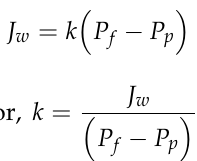
Table 1. Effect of varying feed flow rate on mass transfer coefficient at 60 °C.